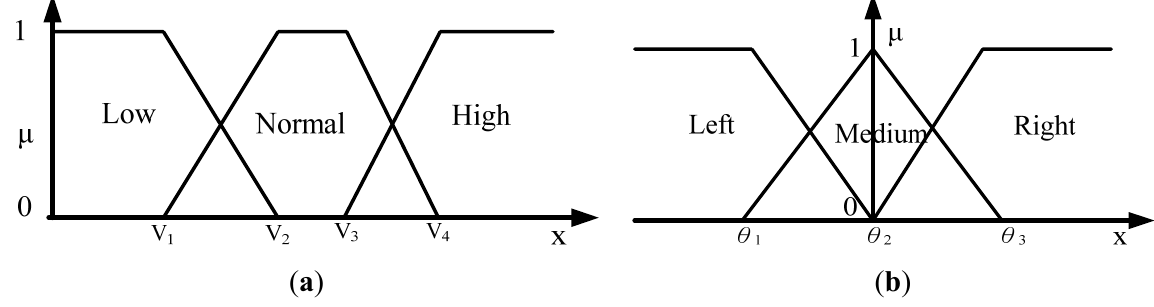
of the steering wheel. ( a ) The fuzzy member functions of speed V . ( b ) The fuzzy member functions of steering wheel θ .